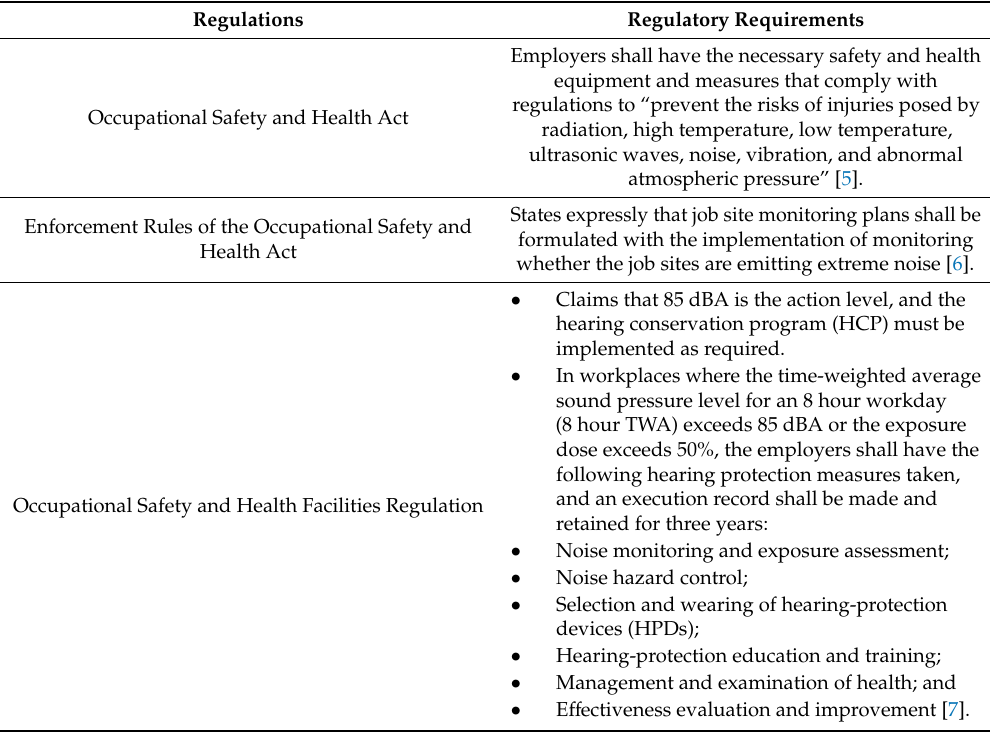
Table 1. The Taiwanese regulations on hearing